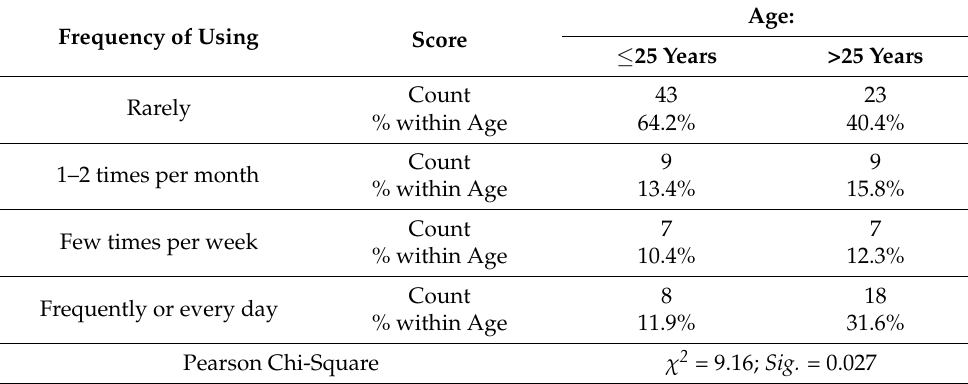
Table 3. The distribution of responses broken down by